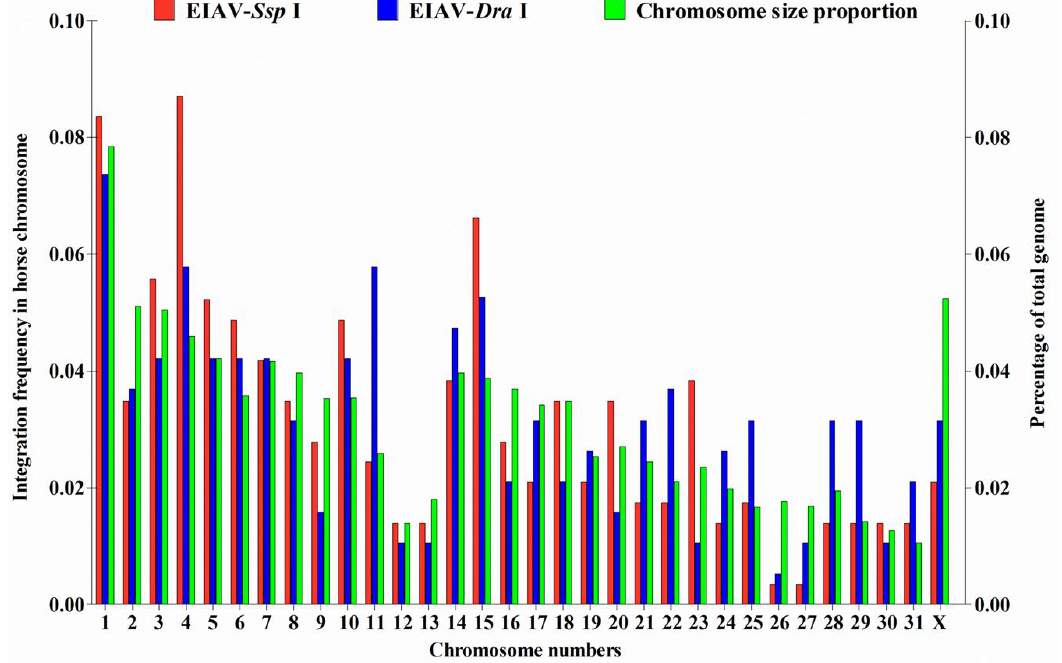
Figure 1. Chromosome distribution of EIAV FDDV13 integration sites in horse chromosomes. Chromosomal DNA of FED cells infected with EIAV FDDV13 was digested with the restriction endonuclease Ssp I or Dra I. Genomic fragments with EIAV integration sites were subcloned after being amplified by LM-PCR. The proportion of integration sites in horse chromosomes digested with Ssp I (287 sites) or Dra I (190 sites) is indicated as a percentage, and the percentage of each corresponding chromosome size was calculated based on the length of the entire horse genome. The chi-squared test was used.